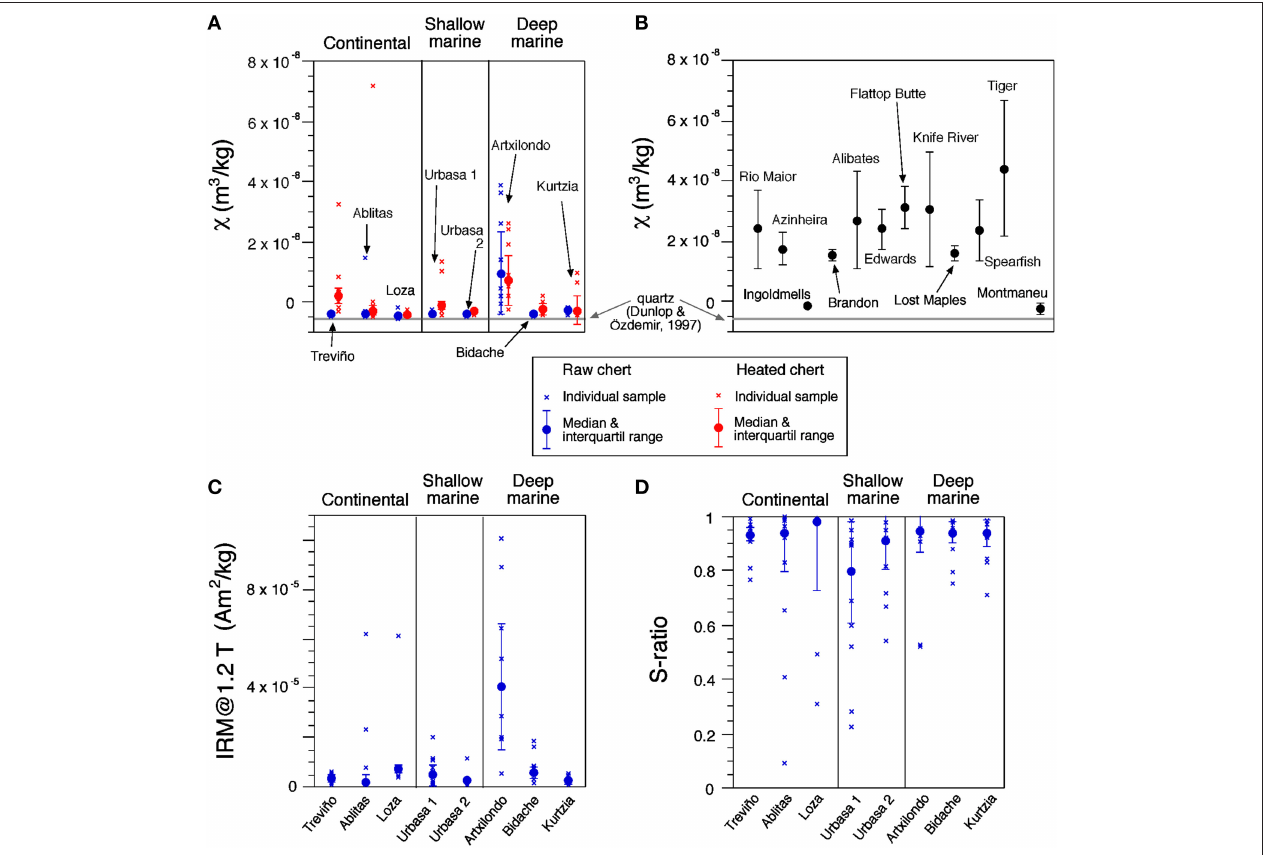
FIGURE 4 | Rock magnetic data for the studied chert samples (crosses) and their comparison with data from other chert types reported in the literature. (A) Magnetic susceptibility of raw (blue) and heated (red) chert types from the Basque-Cantabrian basin and surrounding regions; (B) Magnetic susceptibility data for other natural chert types reported in the literature. Data for Alibates, Edwards, Flattop Butte, Knife River, Spearfish, Lost Maples, Tiger (USA), Brandon (UK) and Rio Maior and Azinheira (Portugal) are after Thacker and Ellwood (2002); data for Ingoldmells (UK) are after Borradaile et al. (1998); data for Montmaneu (Spain) are after Ortega et al. (2016). (C) IRM@1.2T data for the studied natural chert types. (D) S ratios for the studied natural chert types. Whiskers indicate the interquartile ranges around the median values (large dots) but in (B) , where they indicate the standard deviation around the mean values provided in the source